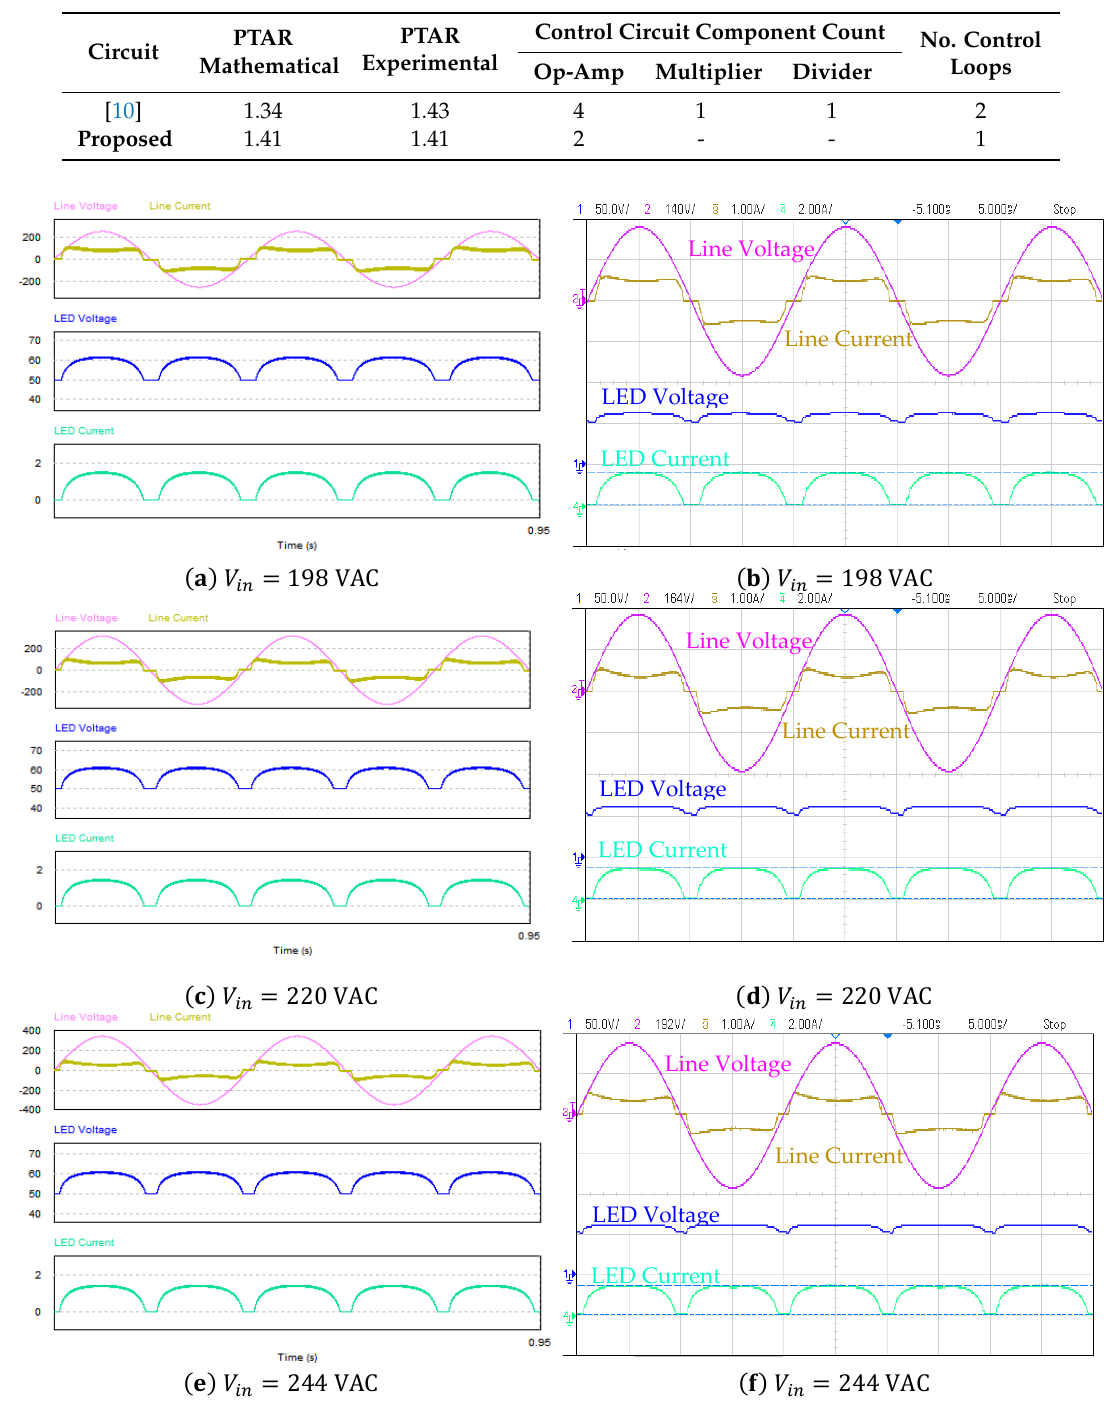
Figure 14. Simulation and prototype waveform results of input voltage 𝑣 𝑖𝑛 , input current 𝑖 𝑖𝑛 , LED output voltage 𝑉 𝑜 and output LED current 𝑖 𝑜 in buck converter.